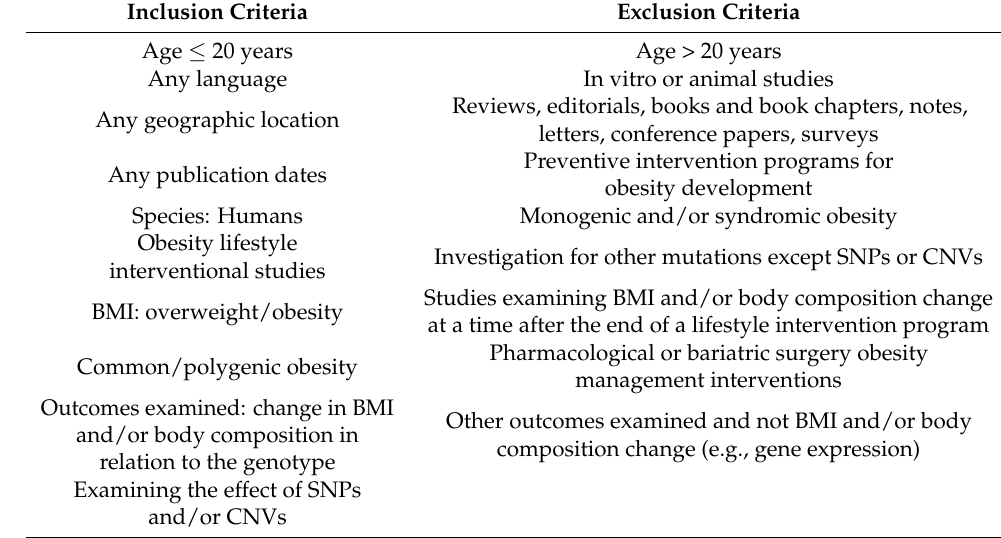
Table 2. Inclusion and Exclusion